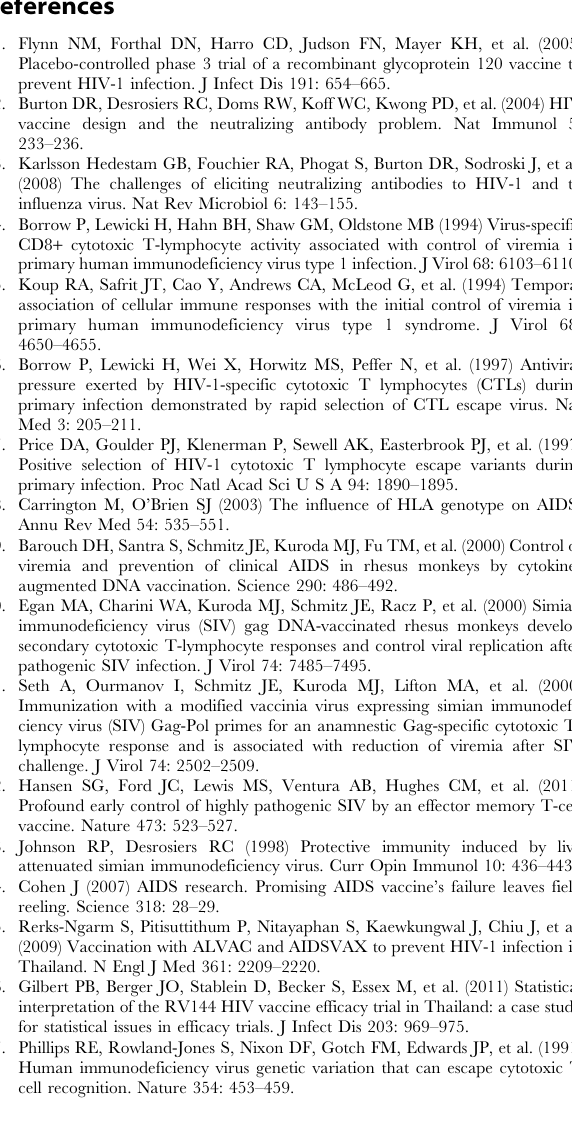
Figure S1 The impact of vaccination is compared for different epidemic dynamics. Figure S2 The impact of a vaccine is dependent upon the extent to which vaccination affects the rate at which escape mutants emerge. Figure S3 The optimal HLA prevalence at any particular epitope can be affected by the nature of the other epitopes included in the